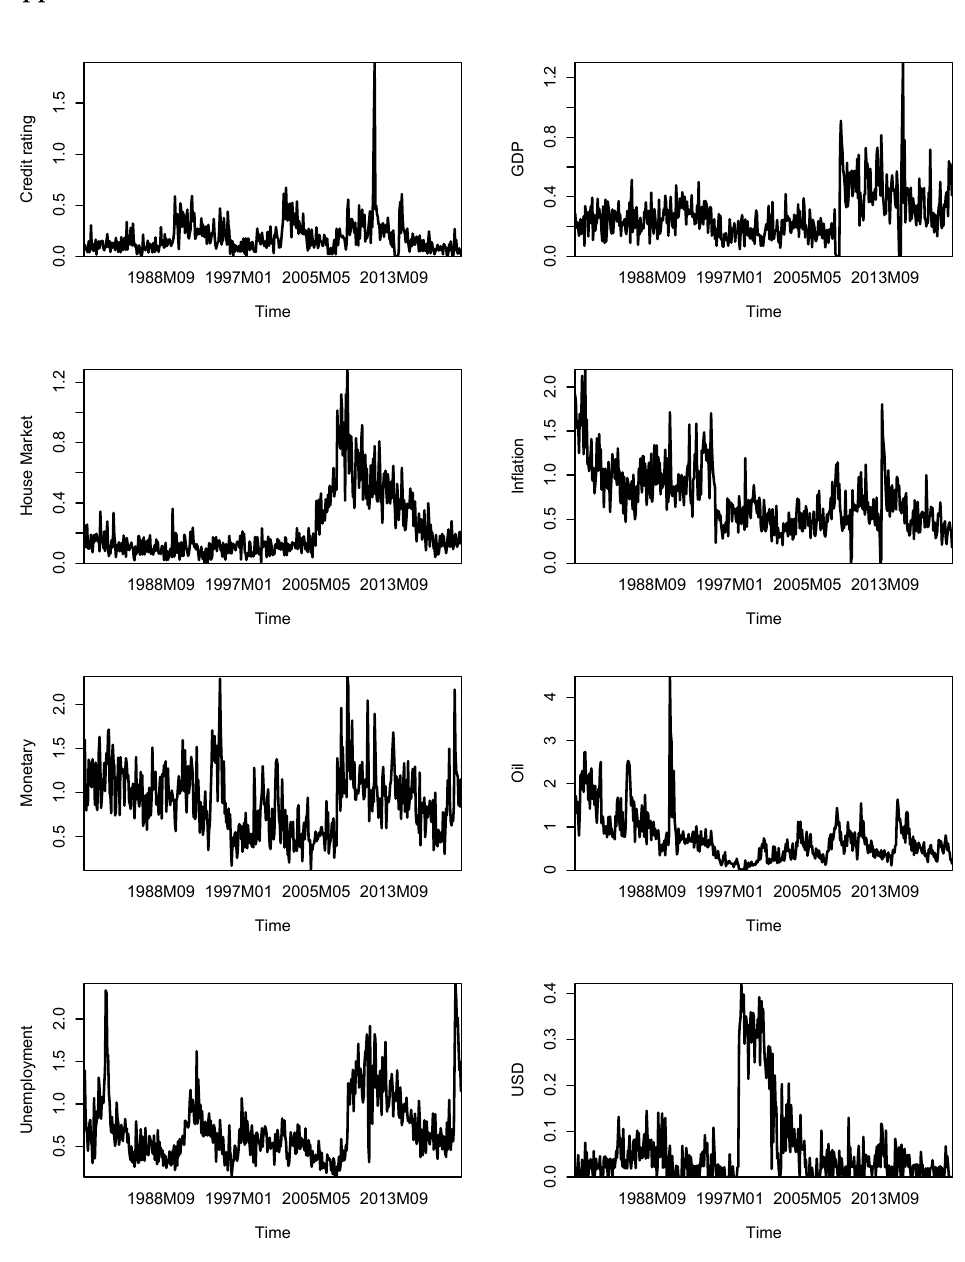
Figure A1. New York Times